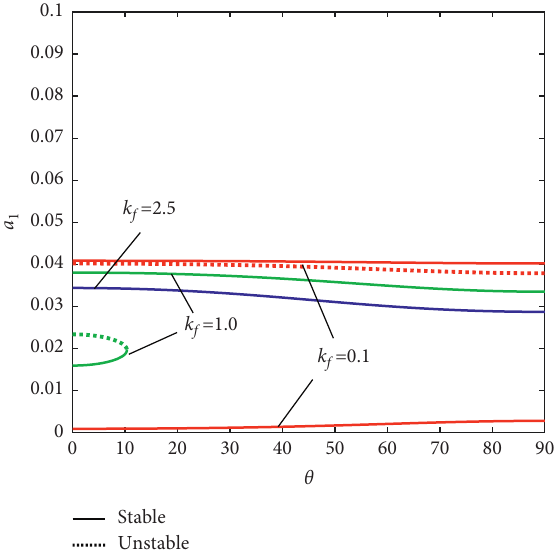
Figure 15: Amplitude versus ply angle with different ratios of length to diameter ( c � 0.01, σ � -1.5, case I).